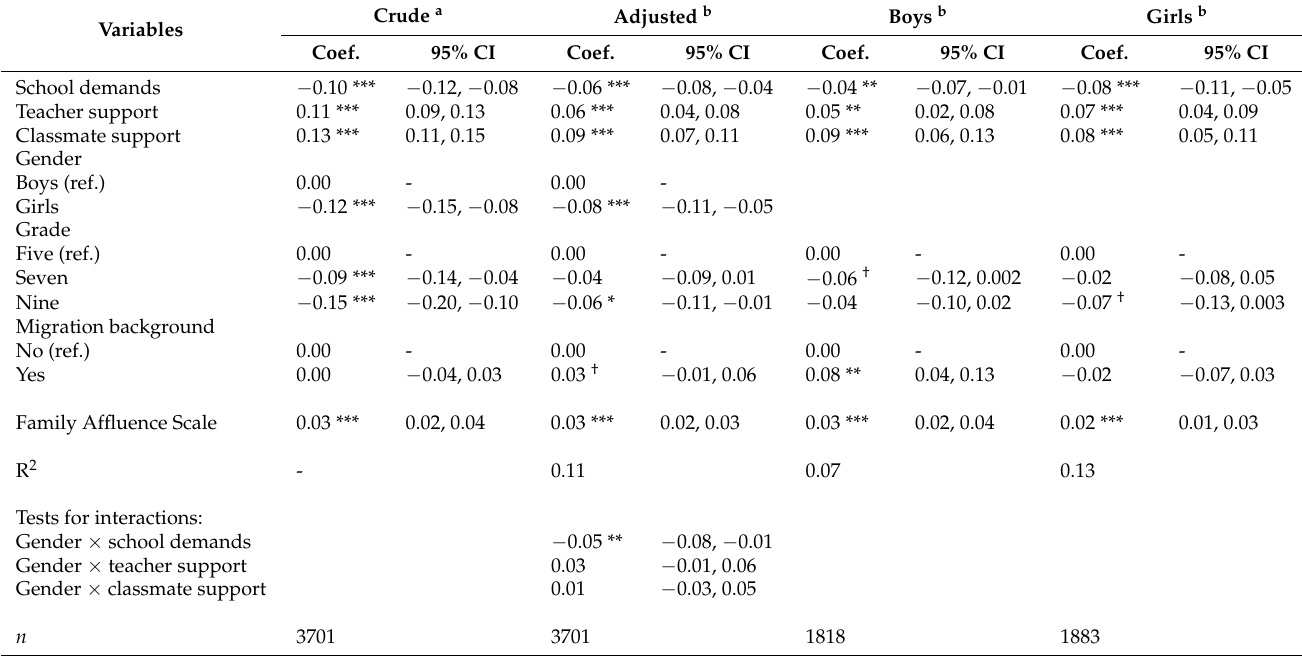
Table 2. Results from the linear probability models of excellent self-rated health ( n = 3701, distributed over 213 classes). Crude a Variables